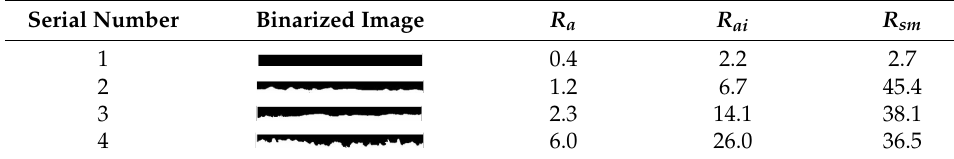
Table 1. Typical sidewall profile parameters of sensitive grids (Units: µ m). Serial